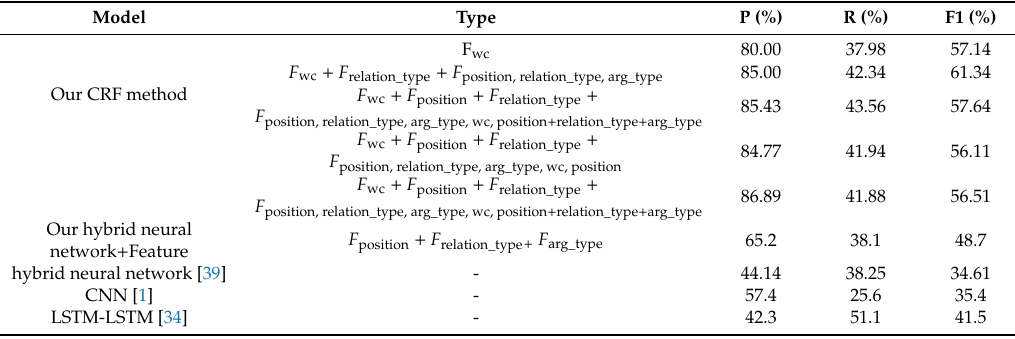
Table 16. CRF model performed while using multiple feature comparisons with the neural network method on the task of relation